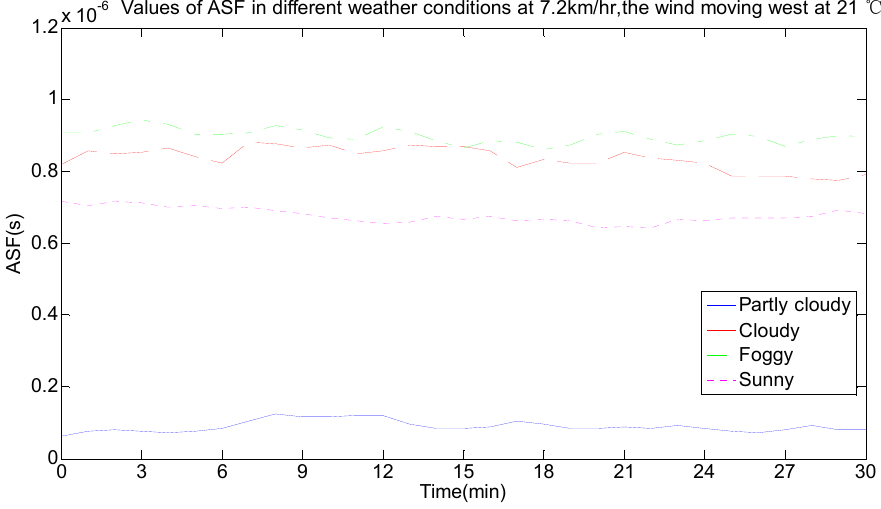
Figure 15. ASF values changing with different weather conditions.